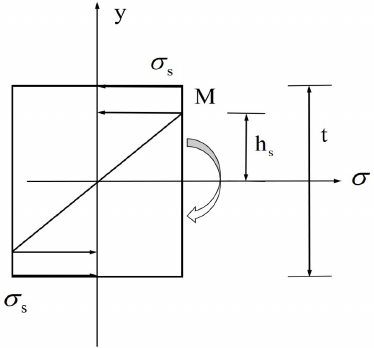
Figure 7. Stress distribution in the thickness